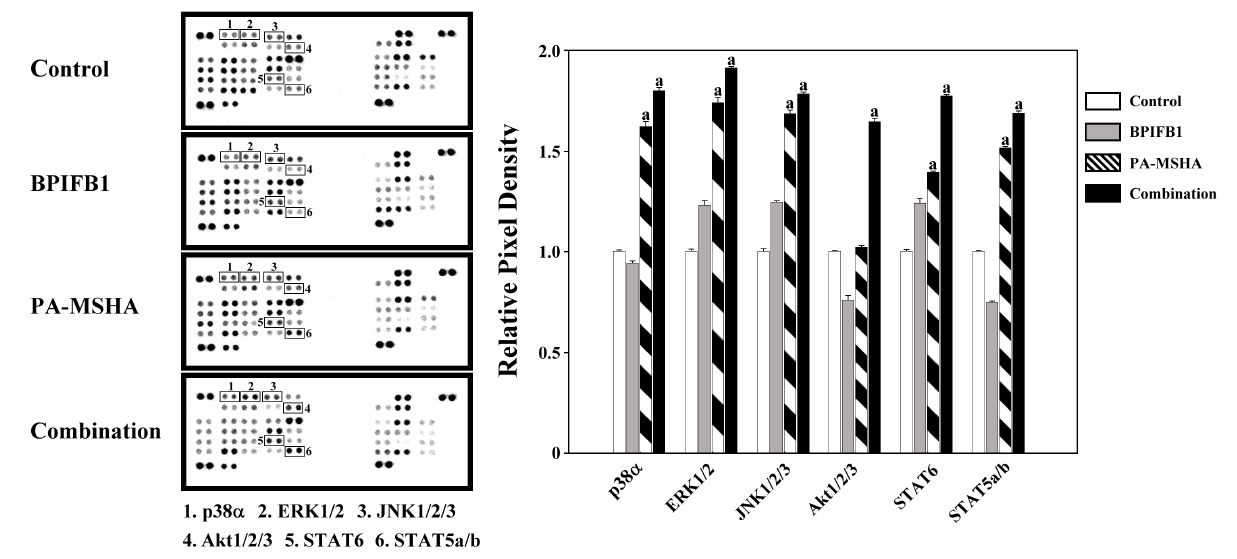
Figure 3: Phosphorylation of kinases was involved in PA-MSHA-BPIFB1 treatment. Approximately 1×10 7 cells with PA-MSHA-BPIFB1treatment were solubilized in lysis buffer. 300 ug of prepared cell lysates and antibodies- conjugated membrane were incubated. After keeping with horseradish peroxidase-conjugated streptavidin, the membranes intensity was acquired using chemiluminescence and pixel densities can be analyzed using Gelpro Analyzer software. Densities were measured as a percentage of the positive controls included on each membrane. Data representative results derived from a minimum of 3 independent experiments. a: p<0.05 compared with none PA-MSHA and BPIFB1